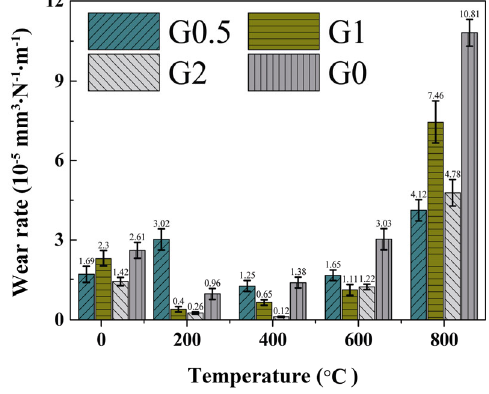
Fig. 6 Wear rates of nickel-alloy based composites as a function of testing temperatures.